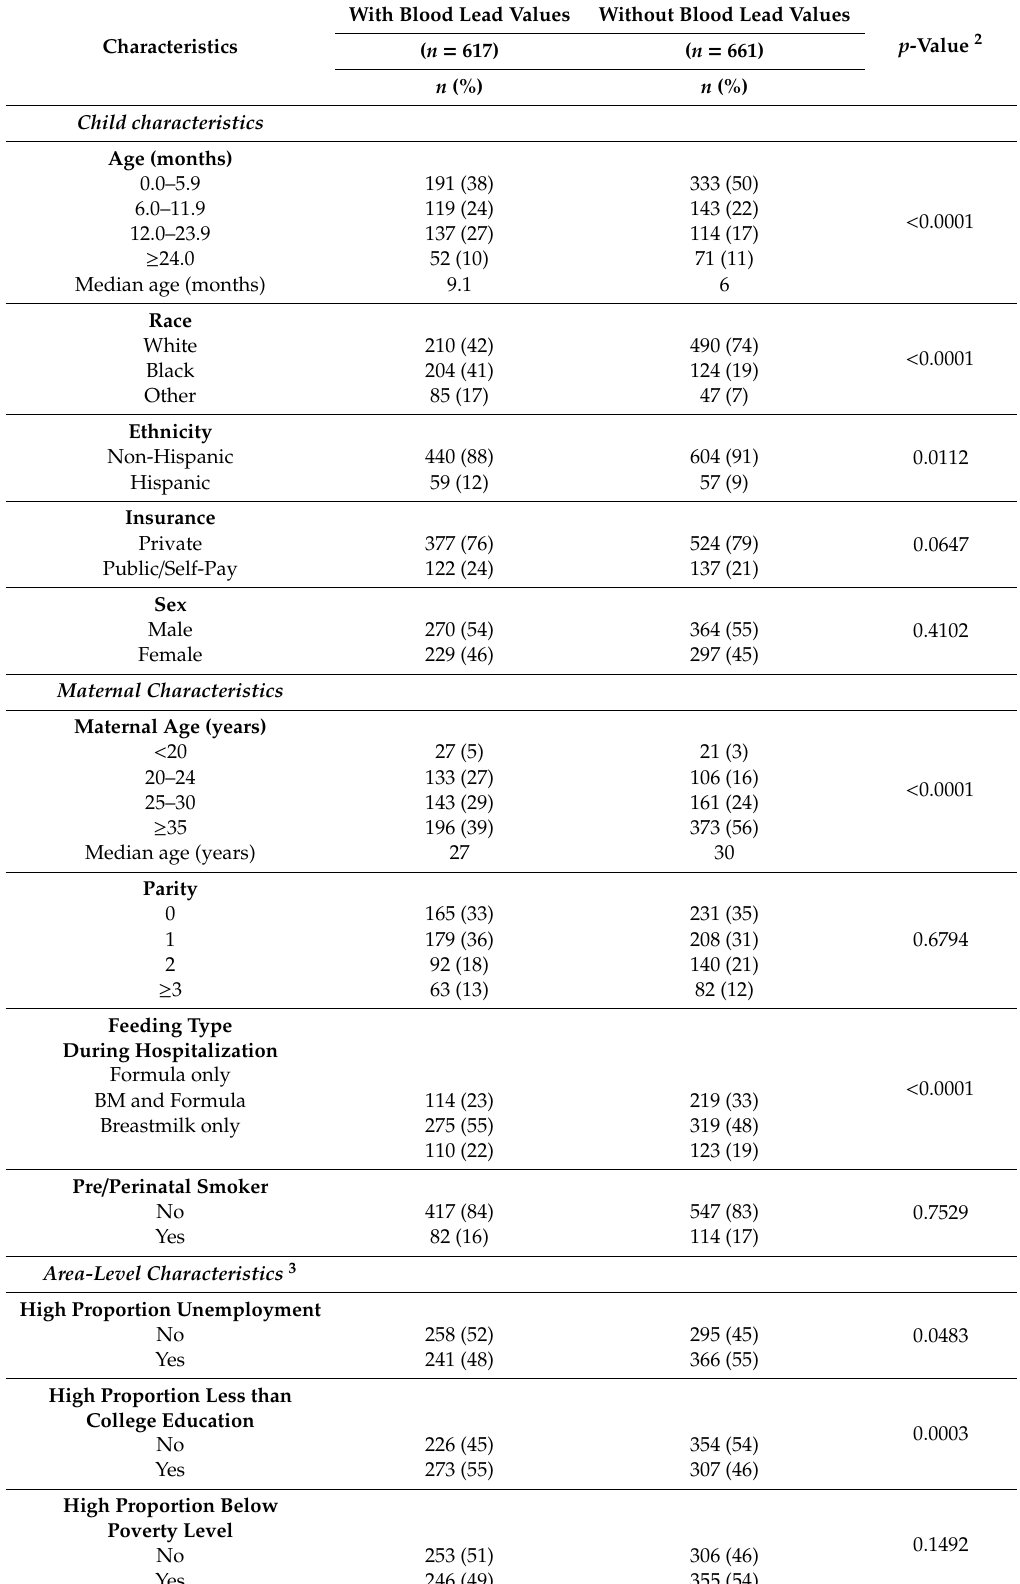
Table 2. Di ff erences in demographic characteristics among children with and without available blood lead values ( n = 1278) 1